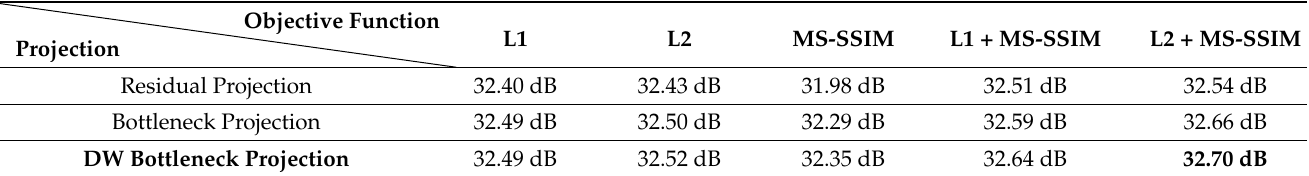
Table 7. Quantitative performance of different objective functions and projection approaches on the Set5 [58] dataset at × 4